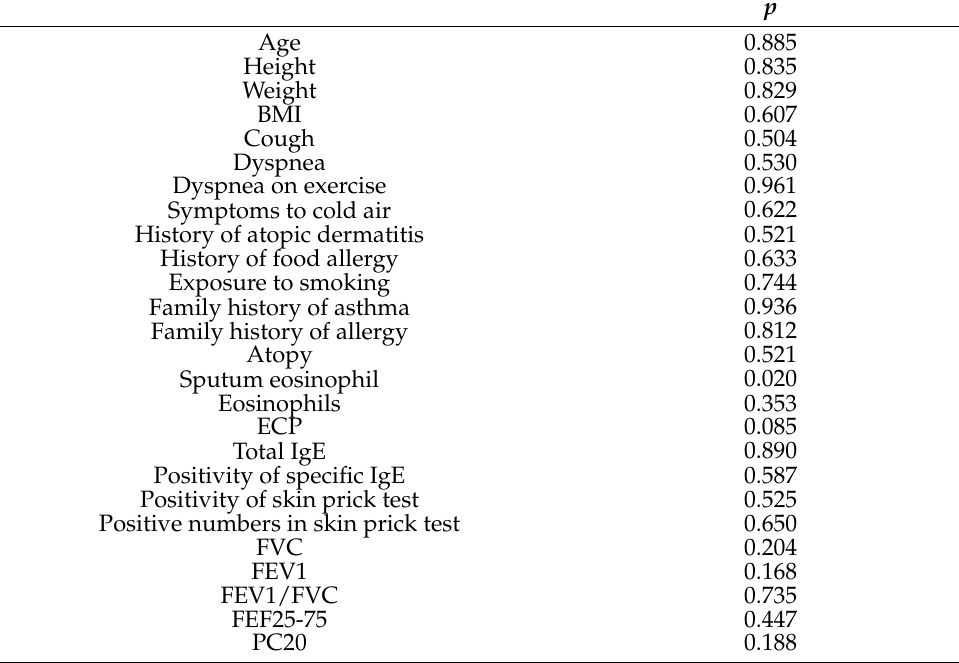
Table 3. Correlations between CDA results and other factors in all